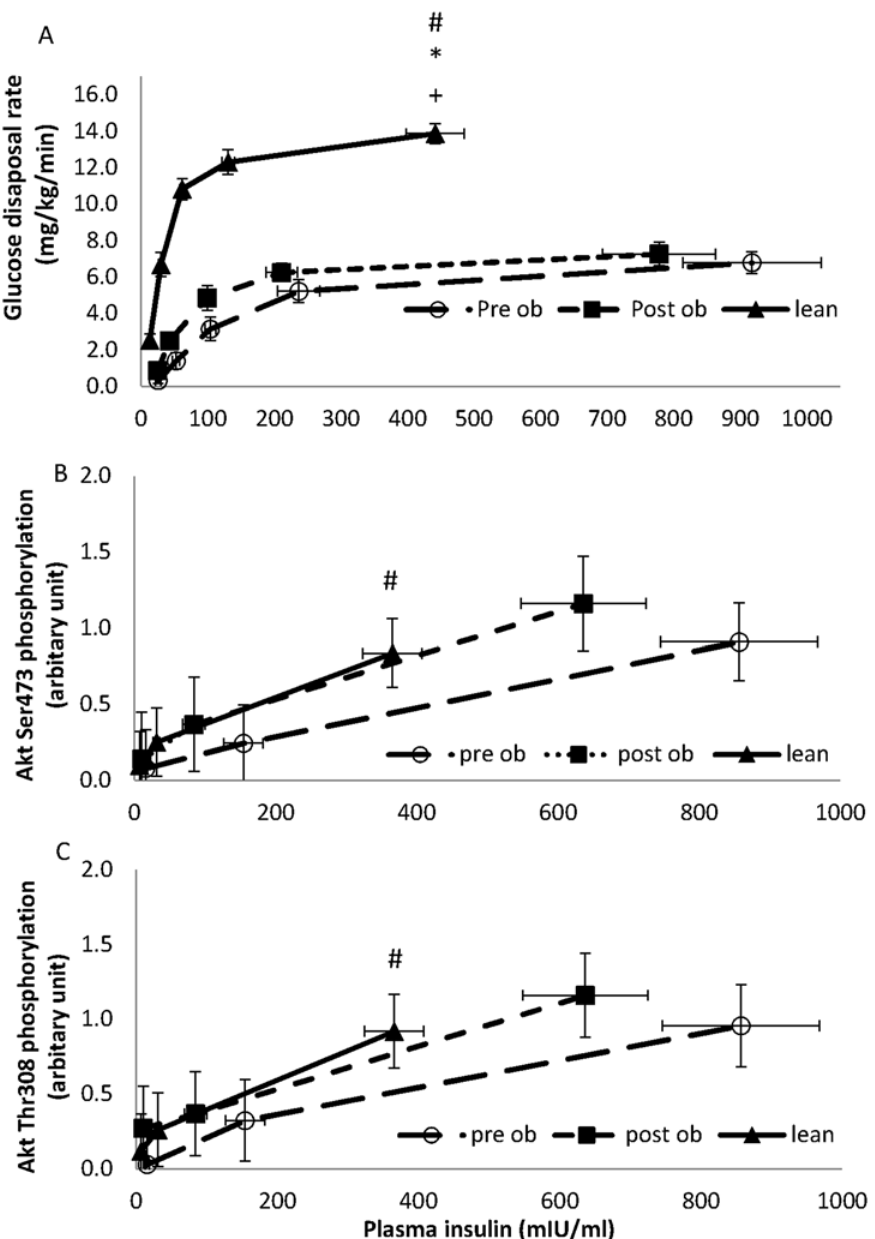
Fig 2. Summary of glucose disposal rates and insulin signalling in lean and obese volunteers, pre and post weight loss surgery. A comparison of glucose disposal (panel A), phosphorylation of Akt on Thr308 (panel B), phosphorylation of Akt on Ser473 (panel C) and phosphorylation of PRAS40 on T426 (panel D) between lean (filled triangles) and obese volunteers before (open circles; pre-op) and after (filled squares; post-op) surgery. The glucose disposal was measured during a 10 hour hyperinsulinaemic euglycaemic clamp with insulin infusion rates of 0.2, 0.5, 1, 2 and 5 mU kg-1 min-1. Data points represent the mean ± SEM with the glucose disposal plotted against the mean insulin concentration achieved at each insulin infusion